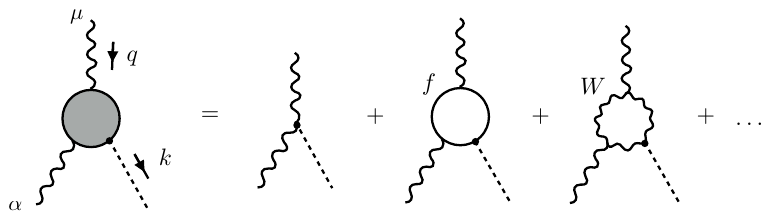
Figure 6 . Representative diagrams contributing to the off-shell ALP-photon vertex at one-loop order in ALP